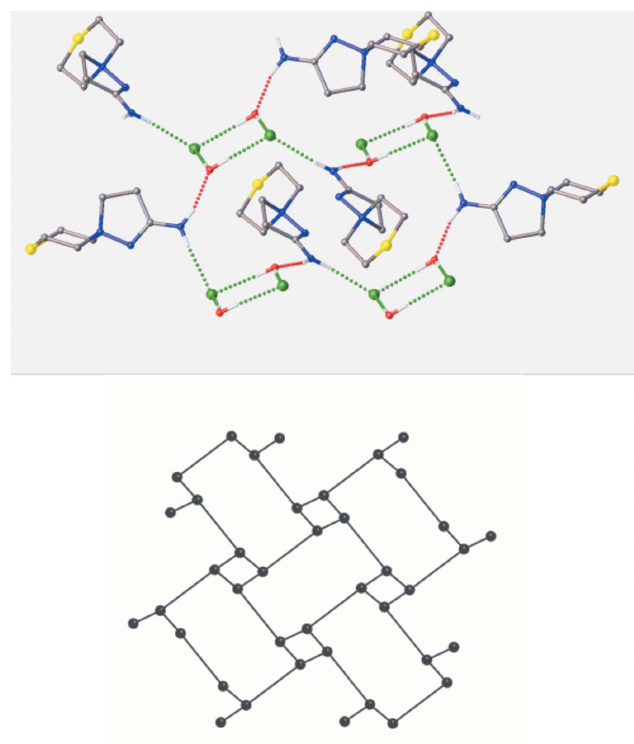
Figure 4 Top: fragment of the hydrogen-bonded layers in 3. Hydrogen bonds are depicted as dotted lines. C-bound H atoms are omitted. Bottom: underlying net of hydrogen bonds in 3 with a fes